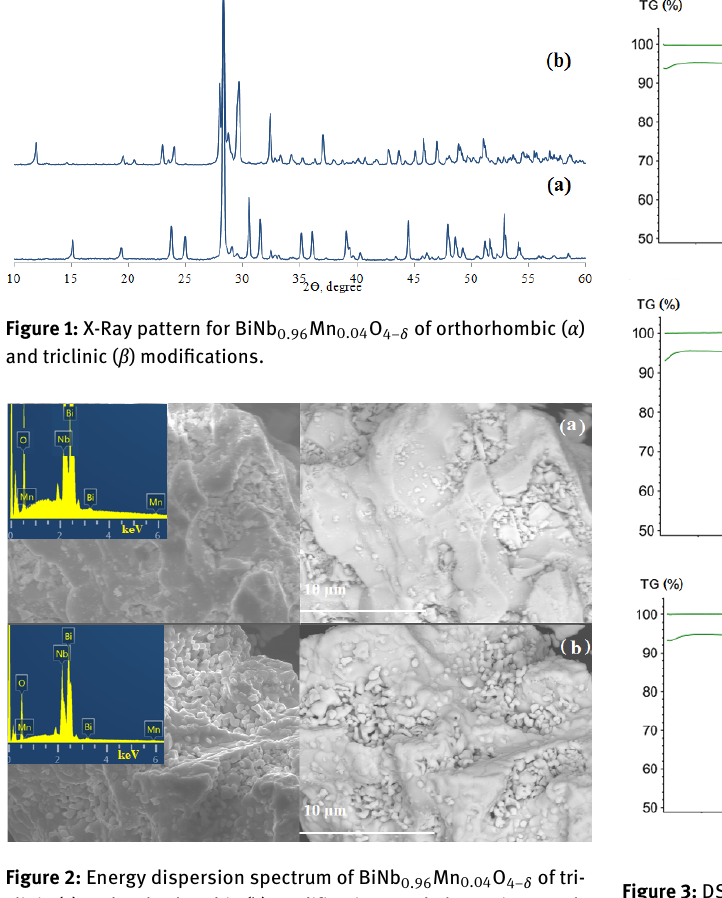
Figure 3: DSC and TG curves of α -BiNb 1− x Mn x O 4− δ at x=0.04 (a), 0.02 (b) and 0.01 (c) in the heating-cooling regime in the interval of 25 ∘ C → 1100 ∘ C → 700 ∘